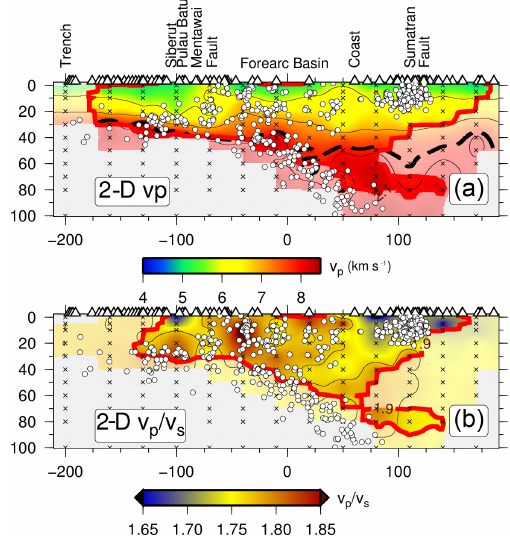
Figure 8. 2-D tomographic velocity models for v p (a) and v p /v s (b) models (profile direction is trench perpendicular). Regions with good resolution are encircled with a red line. Circles indicate hypocenters and grid nodes are shown with crosses. Stations are indicated with triangles. The dashed line in panel (a) indicates the v p 7.8kms − 1 contour line and is used as a proxy for the Moho.